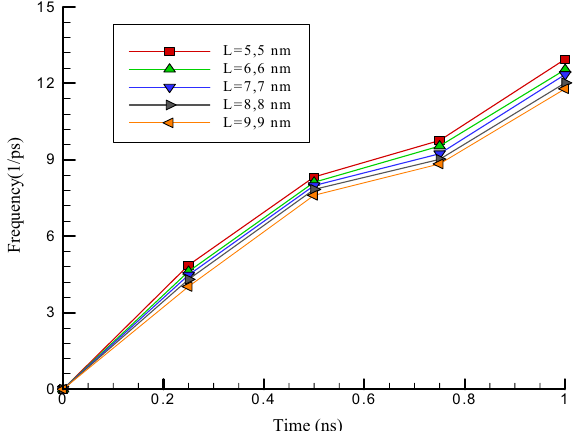
Figure 9. Oscillation frequency changes of carbon nanotubes versus time step with a length of 5 nm in variuos chiralities.